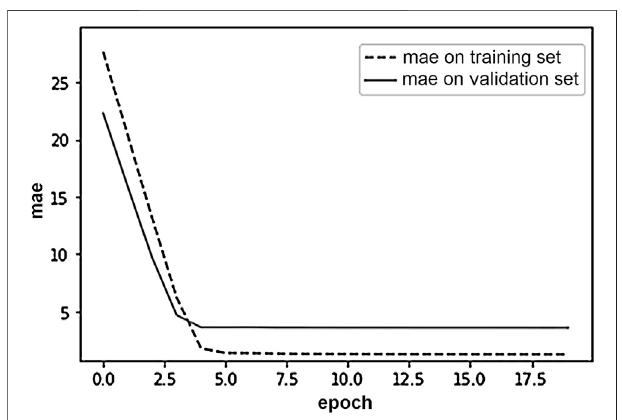
FIGURE 8 | Ensemble training